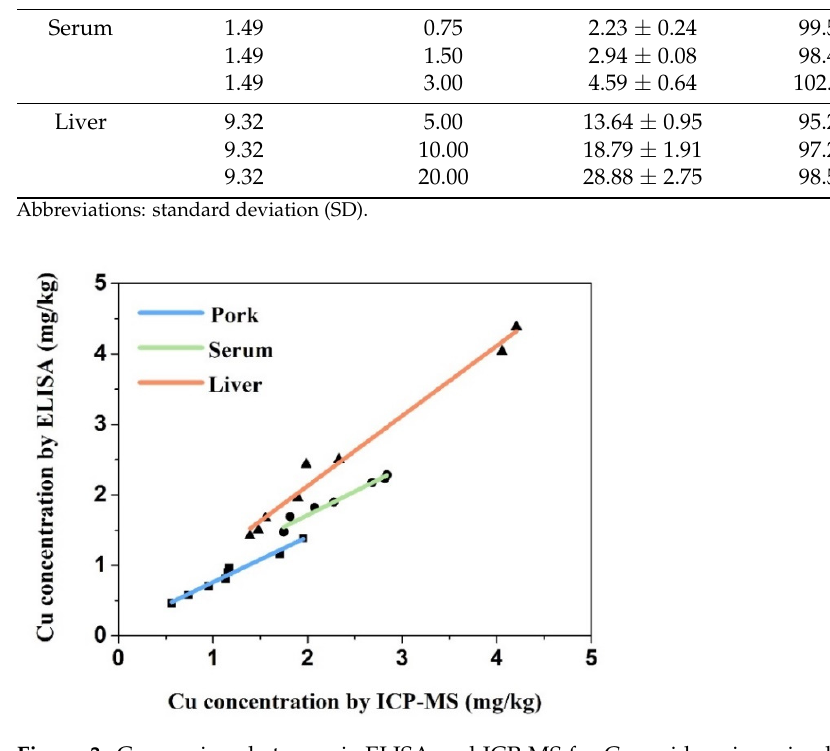
Figure 3. Comparison between ic-ELISA and ICP-MS for Cu residues in swine liver, serum, and pork samples ( ▴ Liver: y = x + 0.141, R 2 = 0.983; ● serum: y = 0.673x + 0.369, R 2 = 0.967; ■ pork: y = 0.645x + 0.118, R 2 = 0.976).